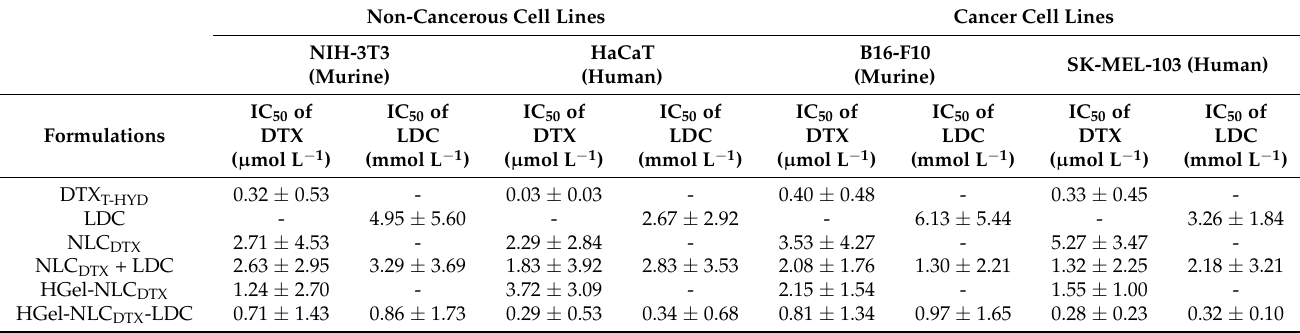
Table 2. IC 50 values of docetaxel (DTX) and lidocaine (free or encapsulated) against NIH-3T3, HaCaT, B16-F10 and SK- MEL-103 cells, after 24 h of treatments, as measured through the MTT assay. Analysis made with the GraphPad Prisma 6.04 software (mean ± SD, n = 3) of the values taken from the curves in Figure